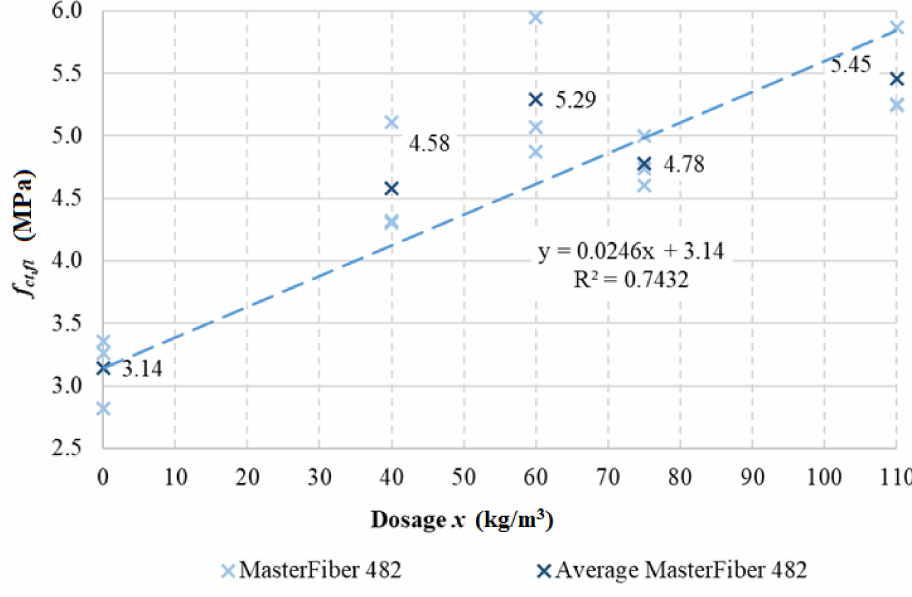
Figure 8. Bending tests of tensile